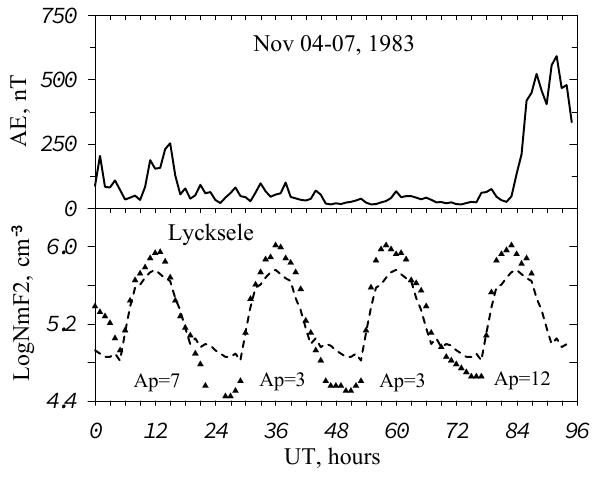
Fig. 4. Fig. 4. A 3-day succession of daytime and nighttime positive Nm F2 disturbances under low or slightly elevated auroral activity. Daily A p indices are also given in the lower panel. Note that the pre-storm nighttime Nm F2 enhancement on 6 May 1968 looks the same as for the previous days. The daytime Nm F2 upsurge after the storm SC on 7 May 1968 is a typical of positive storm phase ( Nm F2 positive disturbance of type